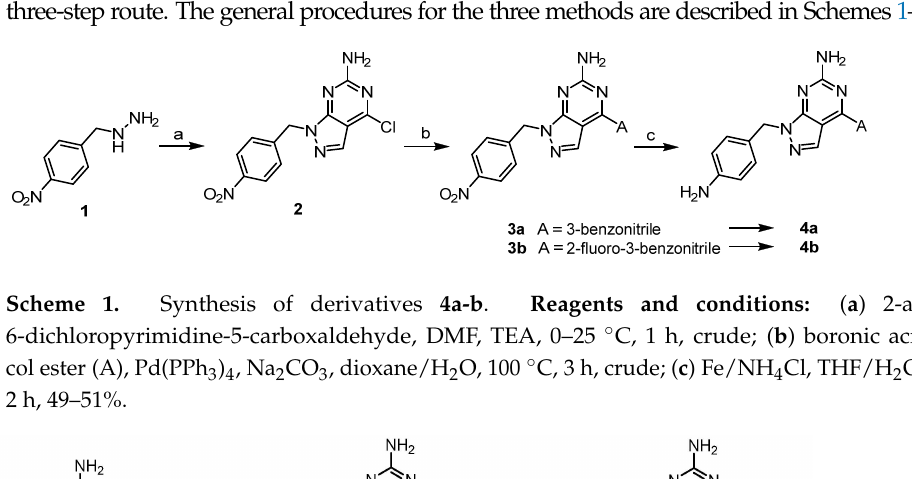
Figure 2. Design of the core structure.